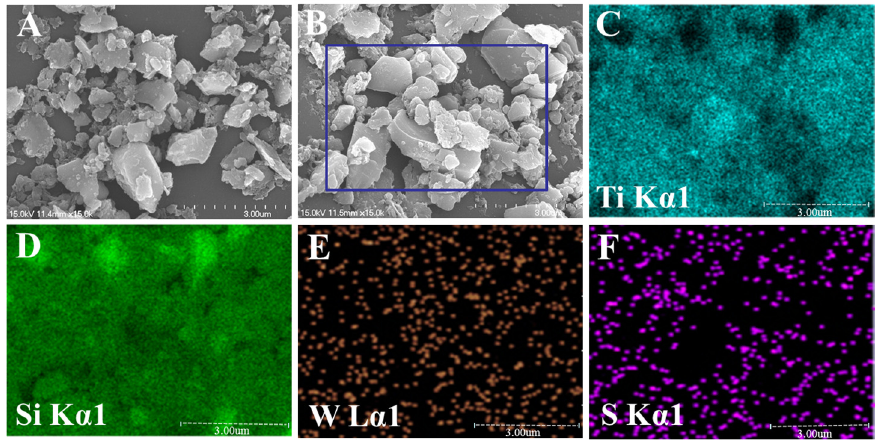
Figure 2. SEM (scanning electron microscopy) images of ( A ) TiSi 2 and ( B ) WS 2 ‐ 1/TiSi 2 ‐ 723; ( C – F ) the corresponding EDX (energy dispersive X ‐ ray spectrometry) mapping of the WS 2 ‐ 1/TiSi 2 ‐ 723 sample at a highlighted region shown in ( B ).